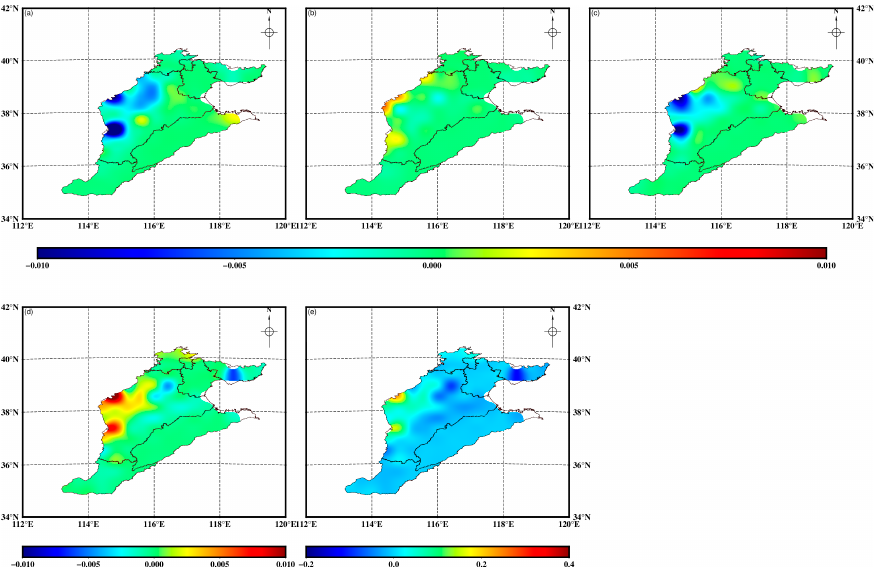
Figure 6. The coefficients obtained using stepwise multivariate linear regression: ( a ) for one-month precipitation predictor (P 1t ); ( b ) for four-month precipitation predictor (P 4t ); ( c ) for twelve-month precipitation predictor (P 12t ); ( d ) for non-precipitation predictor (NP t ); ( e ) represents